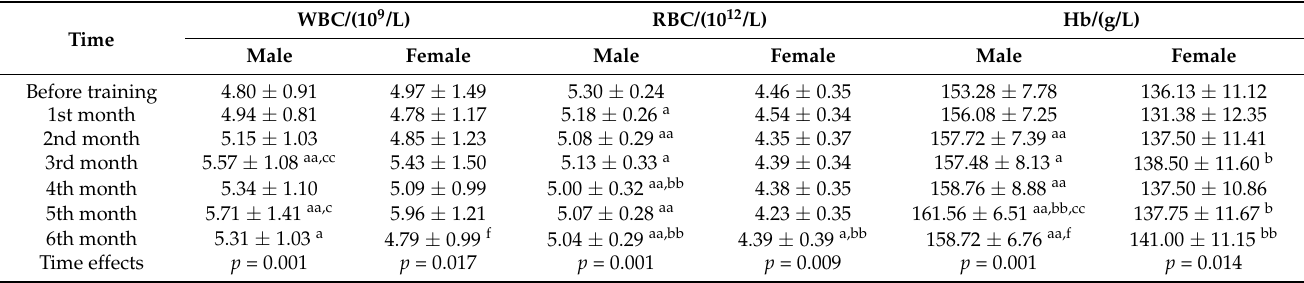
Table 5. Results of leukocyte and red blood cell-related indicators in athletes (cid:48) blood.